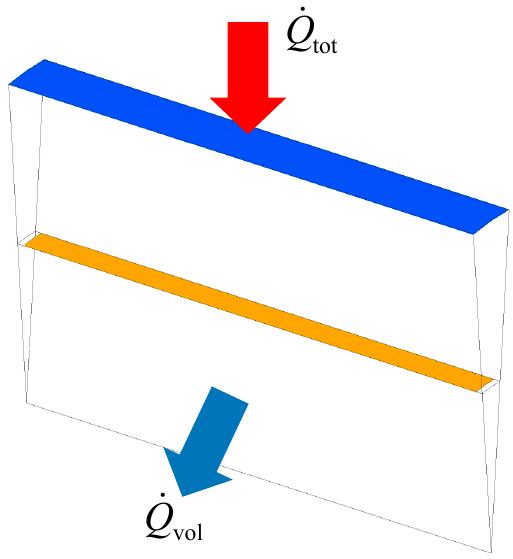
Figure 3. Scheme of the computational domain with supplied and withdrawn heat flux.